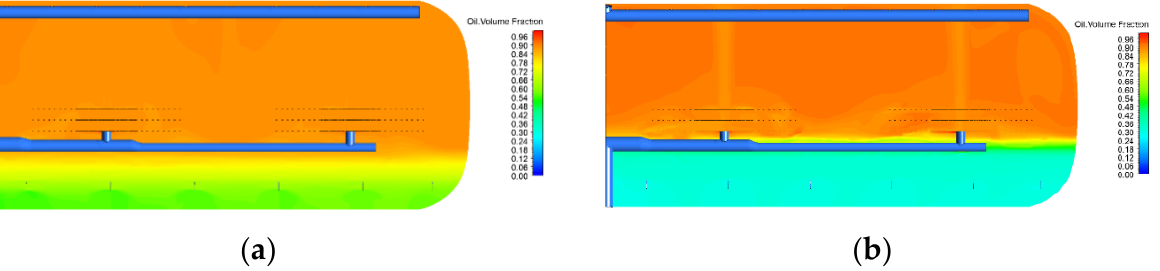
Figure 4. Effect of the temperature (oil viscosity) on the oil volume fraction in a longitudinal plane for ( a ) high viscosity, experiment 12 (D = 20 µm, µ = 0.071 kg/ms, x = 0.12, and E = 0.1 kV/cm); ( b ) low viscosity, experiment 10 (D = 20 µm, µ = 0.017 kg/ms, x = 0.12, and E = 0.1 kV/cm).